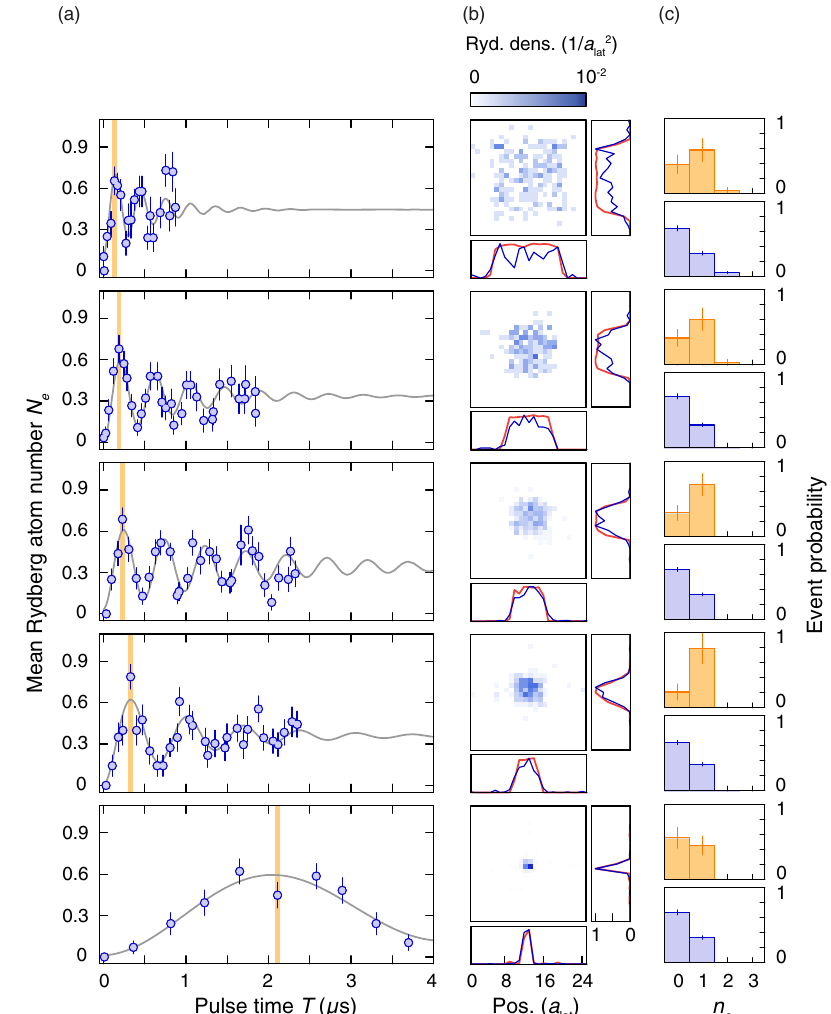
FIG. 2. Collective Rabi oscillations. (a) Collective Rabi oscillation data of the mean Rydberg atom number N different numbers of ground-state atoms N ¼ 185 ð 8 Þ , 84(6), 42(4), 20(3), 0.74(0.60) (top to bottom) with exponentially decaying sinusoidal fits (gray). All error bars are s.e.m. (b) Density of detected Rydberg atoms for the data sets in (a) with normalized vertically or horizontally averaged density (solid blue line) compared to the initial state atom distributions (solid red line). (c) Histograms of the Rydberg excitation number integrated over the total oscillation (blue bars) and at the position of the first maximum [orange bars, position in (a) marked by solid orange